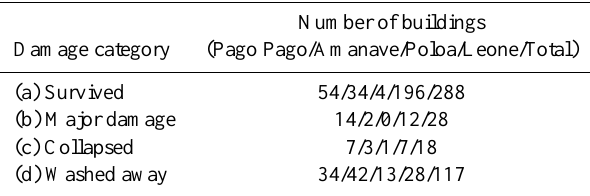
Table 3. Building-damage interpretation